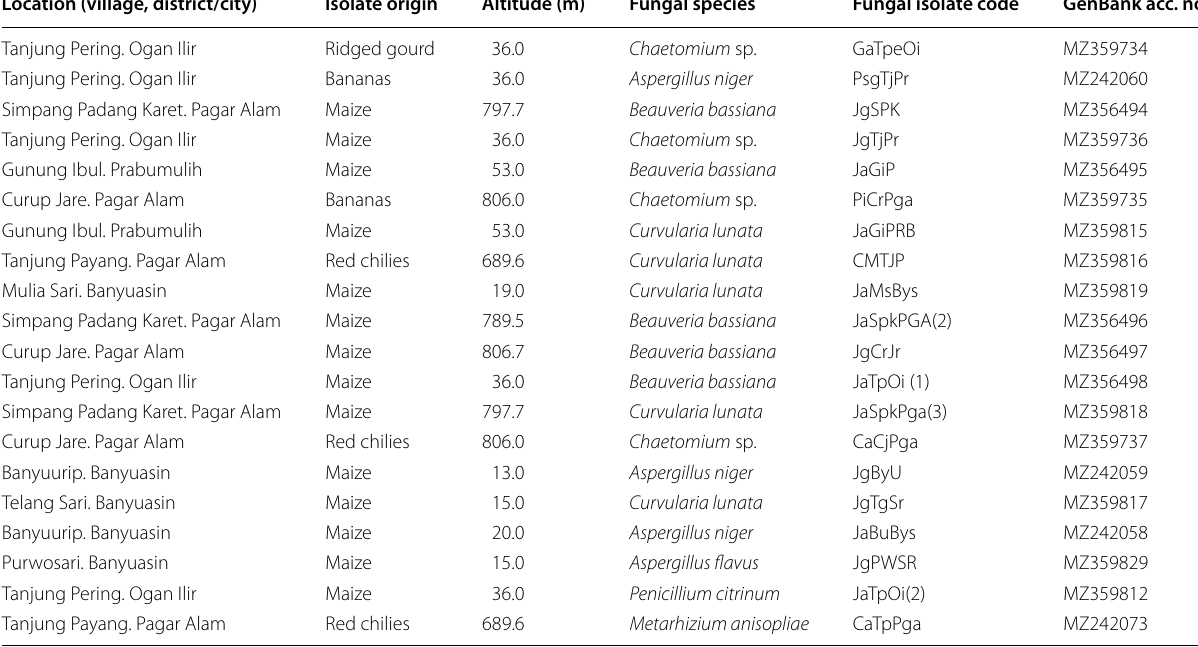
Table 1 Origin of isolates of endophytic fungi from South Sumatra, Indonesia Location (village, district/city) Isolate